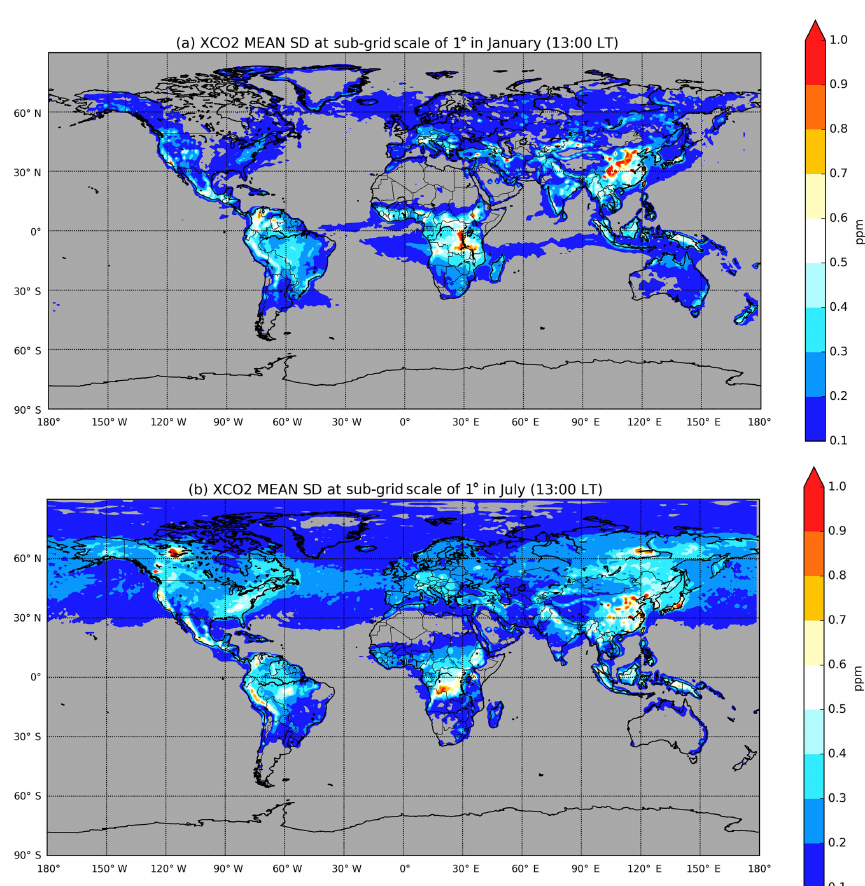
Figure 13. Monthly mean XCO 2 small-scale variability ( σ ) within 1 ◦ × 1 ◦ grid boxes (ppm) at 13:00 local time in (a) January and (b) July. Grey shading denotes σ < 0 .